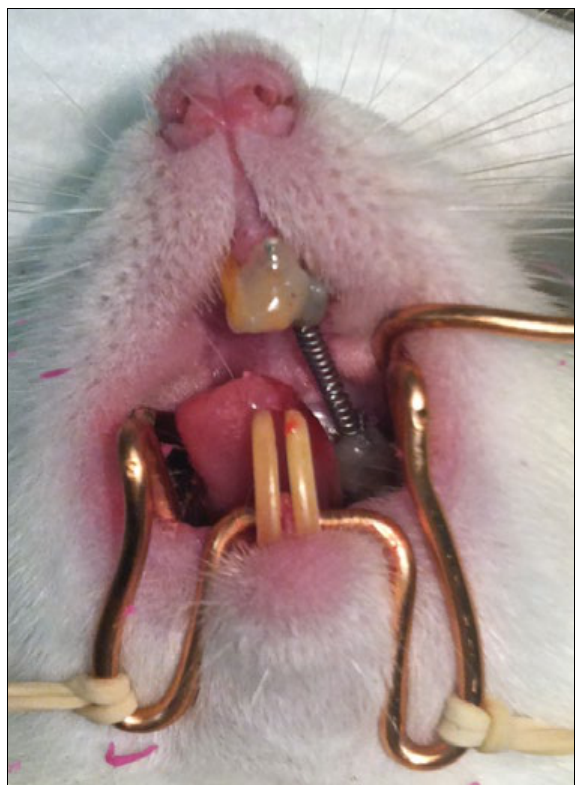
Figure 1. Design of force activation with NiTi coil spring.